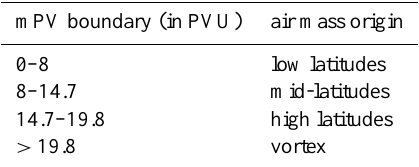
Table 3. Summary of the modified potential vorticity boundaries for the artificial tracers and the corresponding air mass